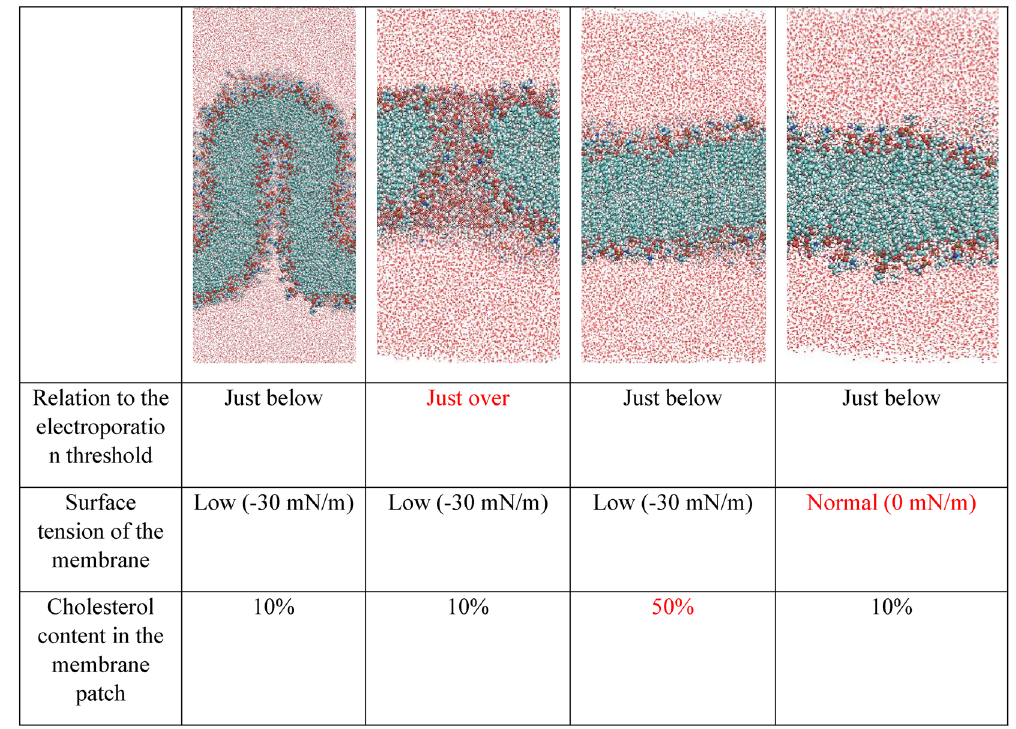
Table 1. Molecular dynamics simulations concerning the effects of electric field on the morphology of the membrane with respect to the electroporation threshold, surface tension of the membrane and cholesterol content in the membrane patch.